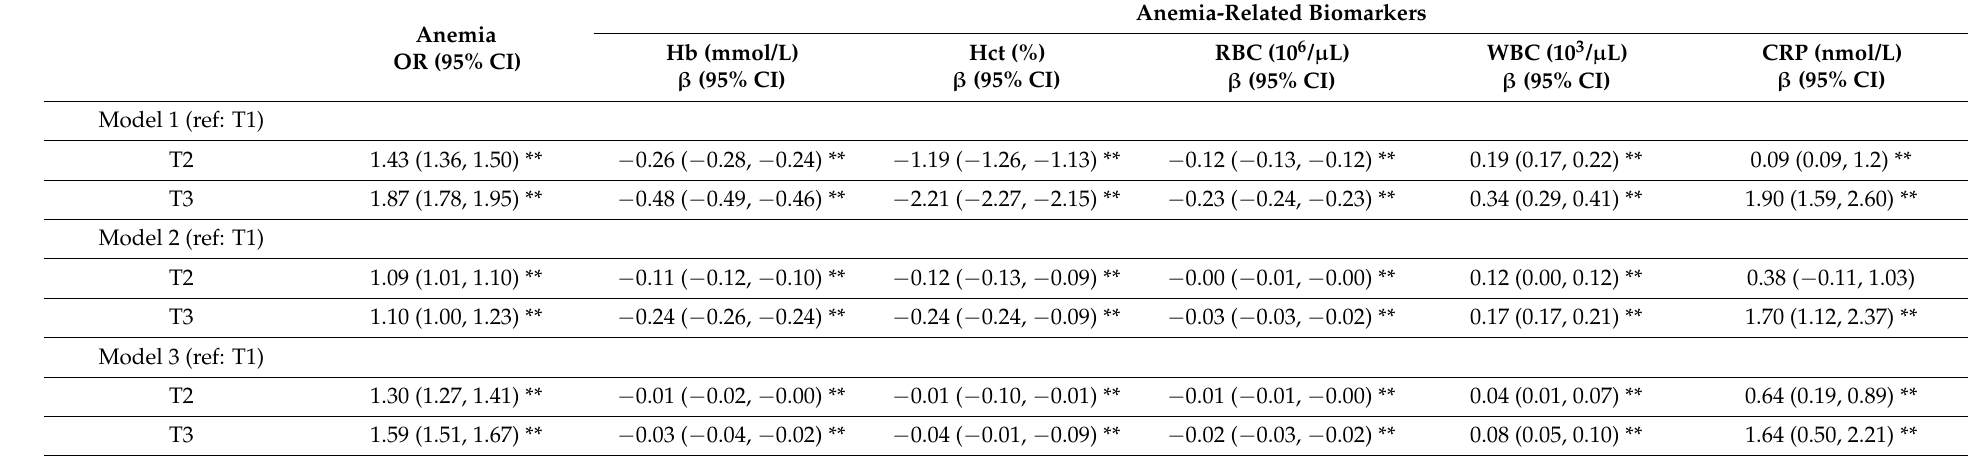
Table 4. Associations between tertiles of dietary pattern, anemia, and anemia-related biomarkers among adults in Taiwan a .